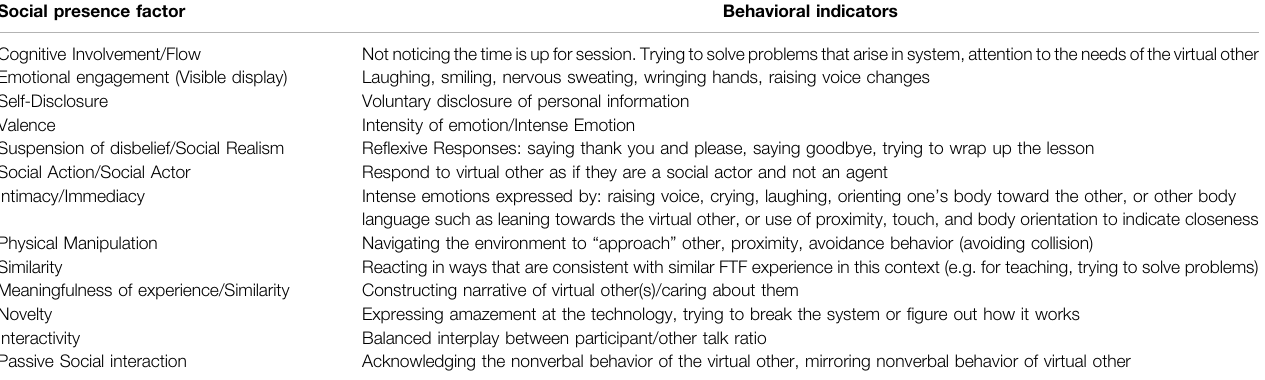
TABLE 1 | Social presence factors and behavioral indicators.